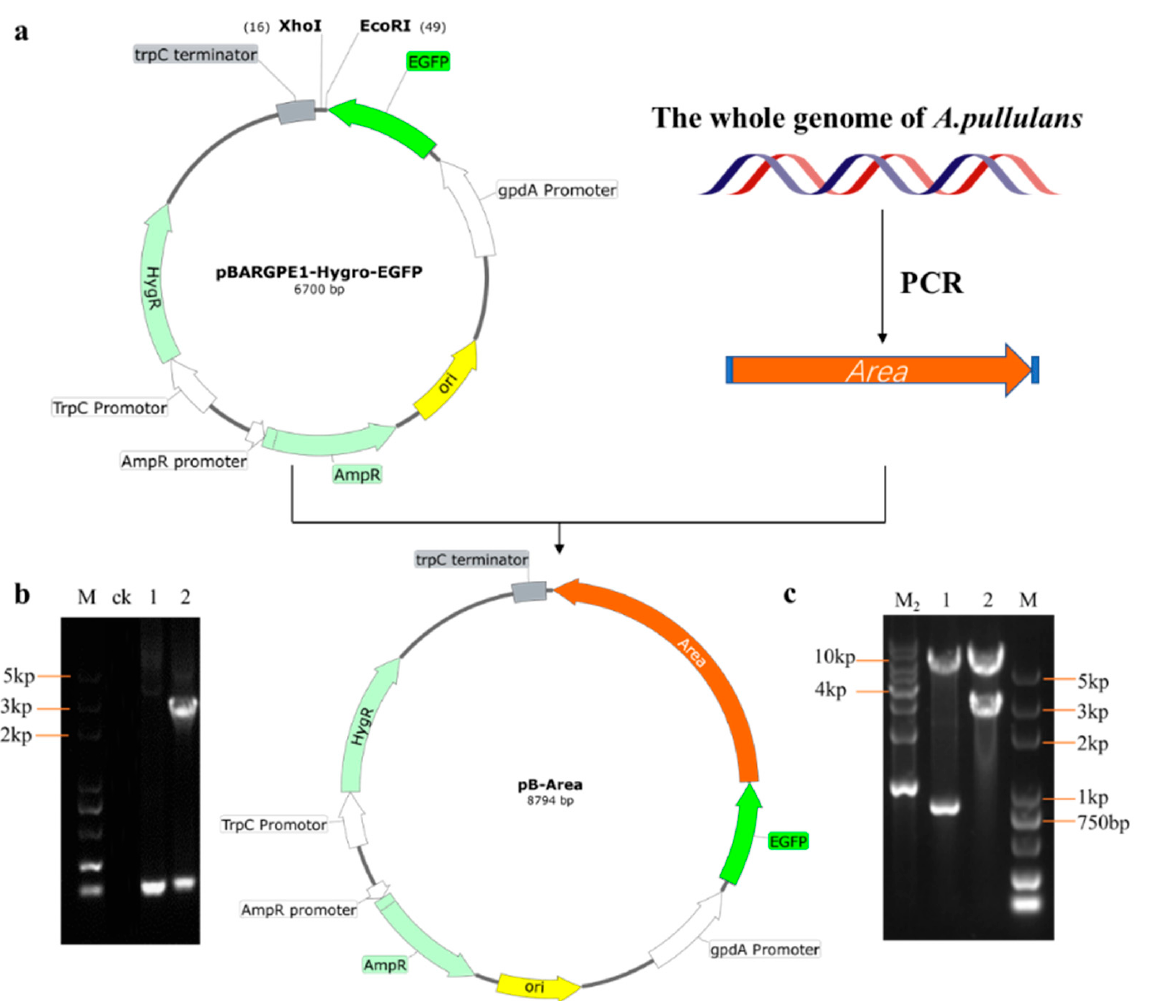
Figure 5. Construction and validation of overexpression vector. ( a ) Construction strategy of Area overexpression vector; ( b ) PCR validation pf pB-Area vector, ck is control, 1 is empty vector, 2 is pB-Area; ( c ) validation of double digestion (BamH Ⅰ and Xho Ⅰ ) on pB-Area vector, 1 is empty vector, 2 is pB-Area.